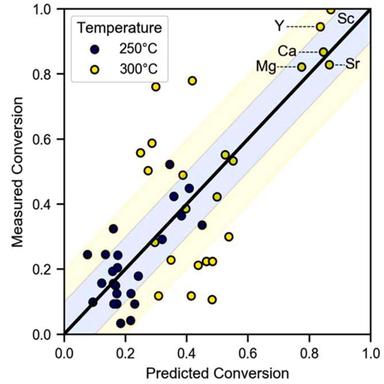
Predicted ammonia conversion for secondary element-substituted catalysts. ML predictions compared to measured conversion using a leave-one-out cross-validation strategy for the entire 3,1,12 RuMK catalyst dataset. The parity line indicates a perfect prediction, the blue band indicates catalyst predictions within 10 % error, and the yellow band indicates catalyst predictions within 20 % error. The secondary element for the best catalysts at 300 ◦C is annotated. Reproduced with permission from American Chemic